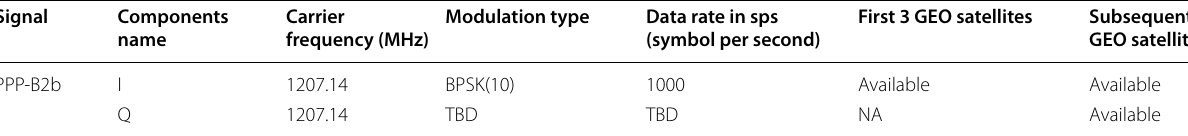
Table 2 Overall plan of PPP-B2b